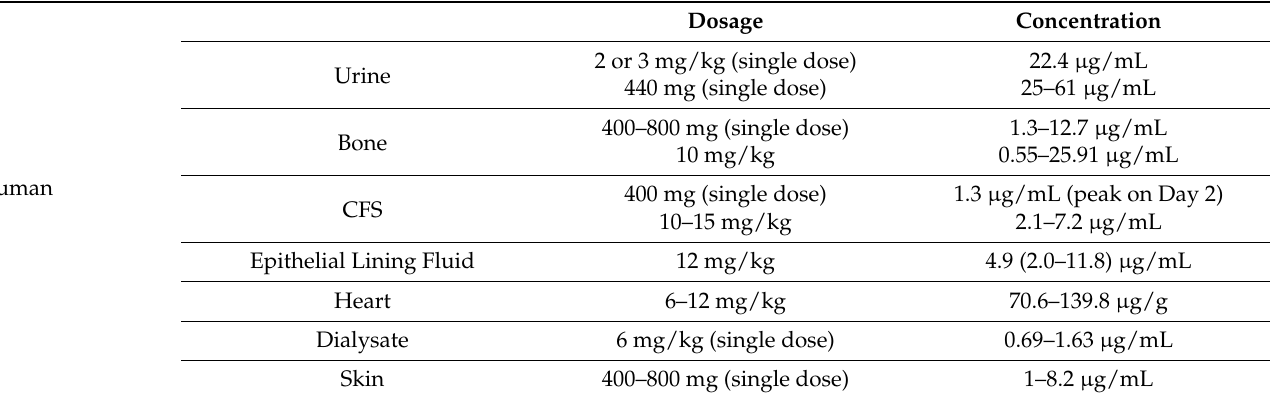
Table 2. Teicoplanin concentrations in different sites of the human body.